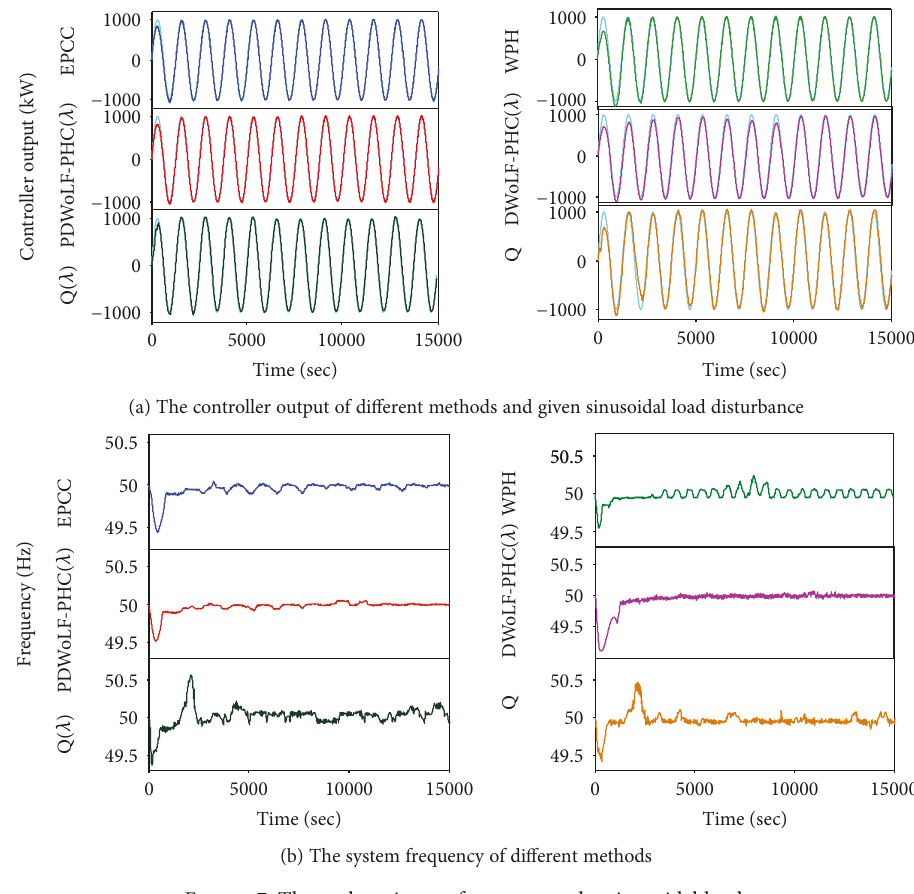
(b) The system frequency of di ff erent methods Figure 7: The prelearning performance under sinusoidal load.